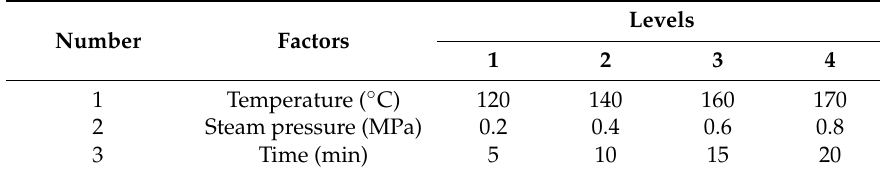
Table 1. Factors and levels of the orthogonal array.